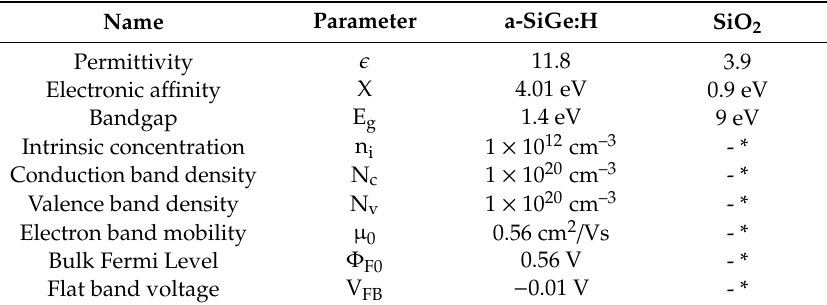
Table 1. Electrical parameters for a-SiGe:H and SiO 2 layers